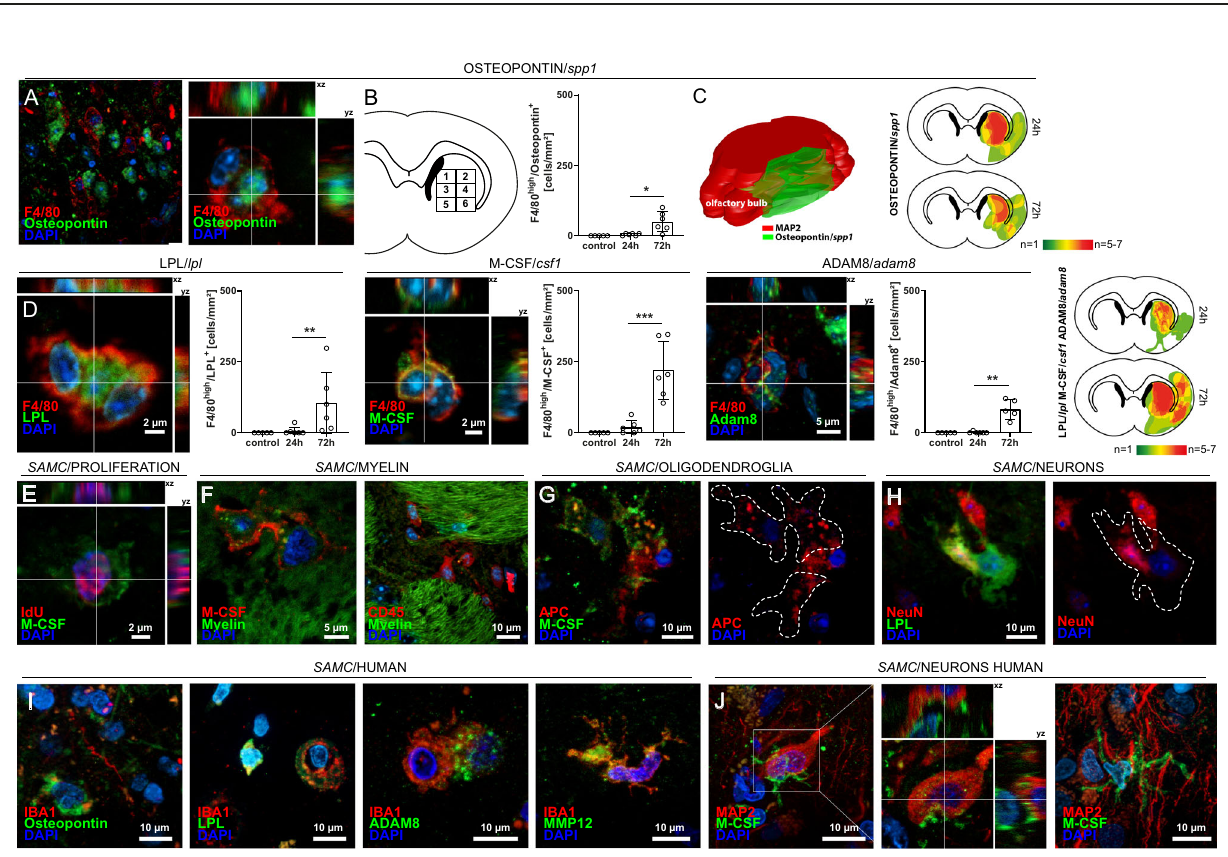
Fig. 3 The stroke-associated myeloid cell (SAMC) phenotype partially resembles early embryonic microglia and upregulates genes of lipid metabolism. A Feature Plots of selected marker genes speci fi cally enriched (Methods) in the SAMC cluster; termed stroke-associated myeloid cells in the text. B Gene score feature plot of the top 10 genes speci fi cally expressed in the SAMC cluster at 24 h post-ischemia. C Dual color feature plot of Spp1 and Lpl . D Dual color feature plot of Fabp5 and Gpnmb . E All cells assigned to the SAMC cluster were submitted to the mouse cell atlas (MCA) and compared with public single-cell datasets. Each column represents one cell, each row represents one MCA reference cell type. Colors indicate Pearson correlation coef fi cient between the top MCA cell types and the submitted cells. Labeled are reference datasets with a high Pearson correlation across multiple cells. F Gene score feature plot using the Top25 marker genes of postnatal day 7 microglia cells (P7-C1) from 39 . G Gene score feature plot using the Top30 marker genes of axon tract-associated microglia cells (P4/5) from 30 .